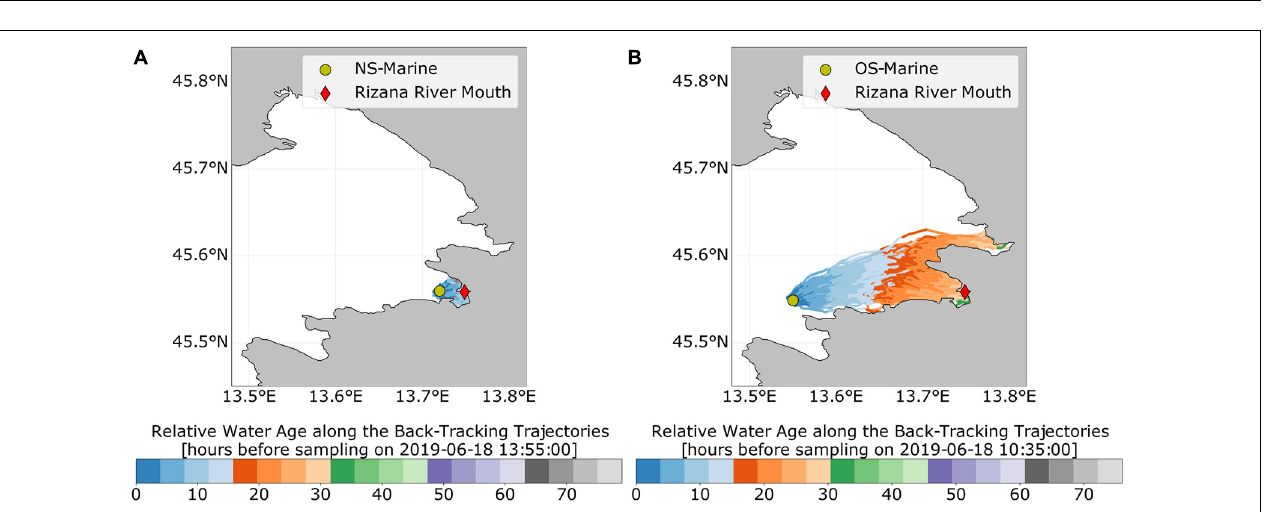
FIGURE 4 | Proportion estimates of the estuarine (R-Estuary-1) and submarine (SM-Outfall) outfall bacterial communities at the surface and bottom layer in winter, spring, summer, and autumn in the 2018/2019 data set in the eastern part of the Gulf of Trieste (at sampling stations: R-Estuary-1, R-Estuary-2, NS-Marine, OS-Marine and SM-Outfall), using “SourceTracker.” Unknown—refers to the fraction of the communities’ source of which was not identified by the SourceTracker.